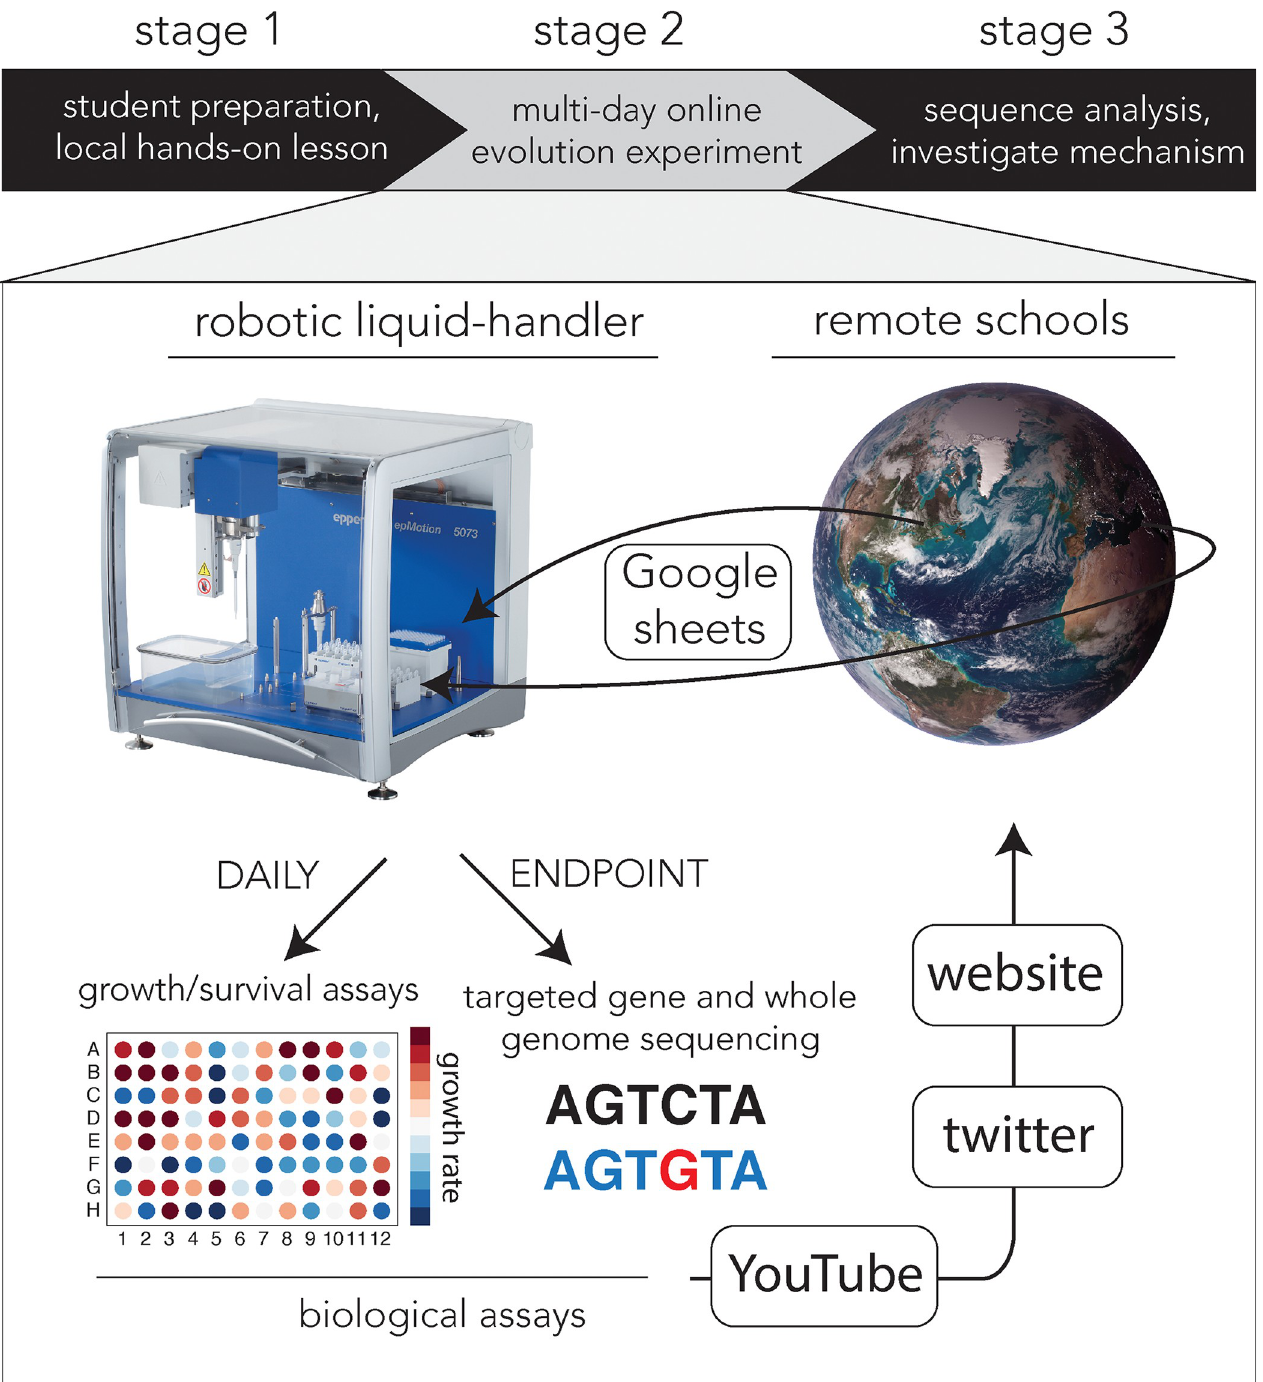
Fig 1. Overview of information flow during the online evolution experiment. The interactive evolution experiment was the second stage in the outreach project and took place over a period of 10 days. On a daily basis, students used online Google sheets to inform a robotic liquid handler on a drug regimen they wanted to implement (drug type and concentration). Liquid handling operation (plate preparation and culture dilution) was streamed as a live broadcast on YouTube by two onboard cameras. We shared systematic reports on culture growth rate by posting them on the project’s website and also shared photos showing bacterial confluences in the discussion forum and on Twitter. The daily results were used by students to make informed decisions on changes in the drug regimen for the following day. At the end of the experiment, sequences and reports from targeted and whole-genome sequencing were shared with students to provide clues on the potential molecular mechanisms underlying evolved drug resistance. Earth photograph (GSFC_20171208_Archive_e002131) : NASA image and video library